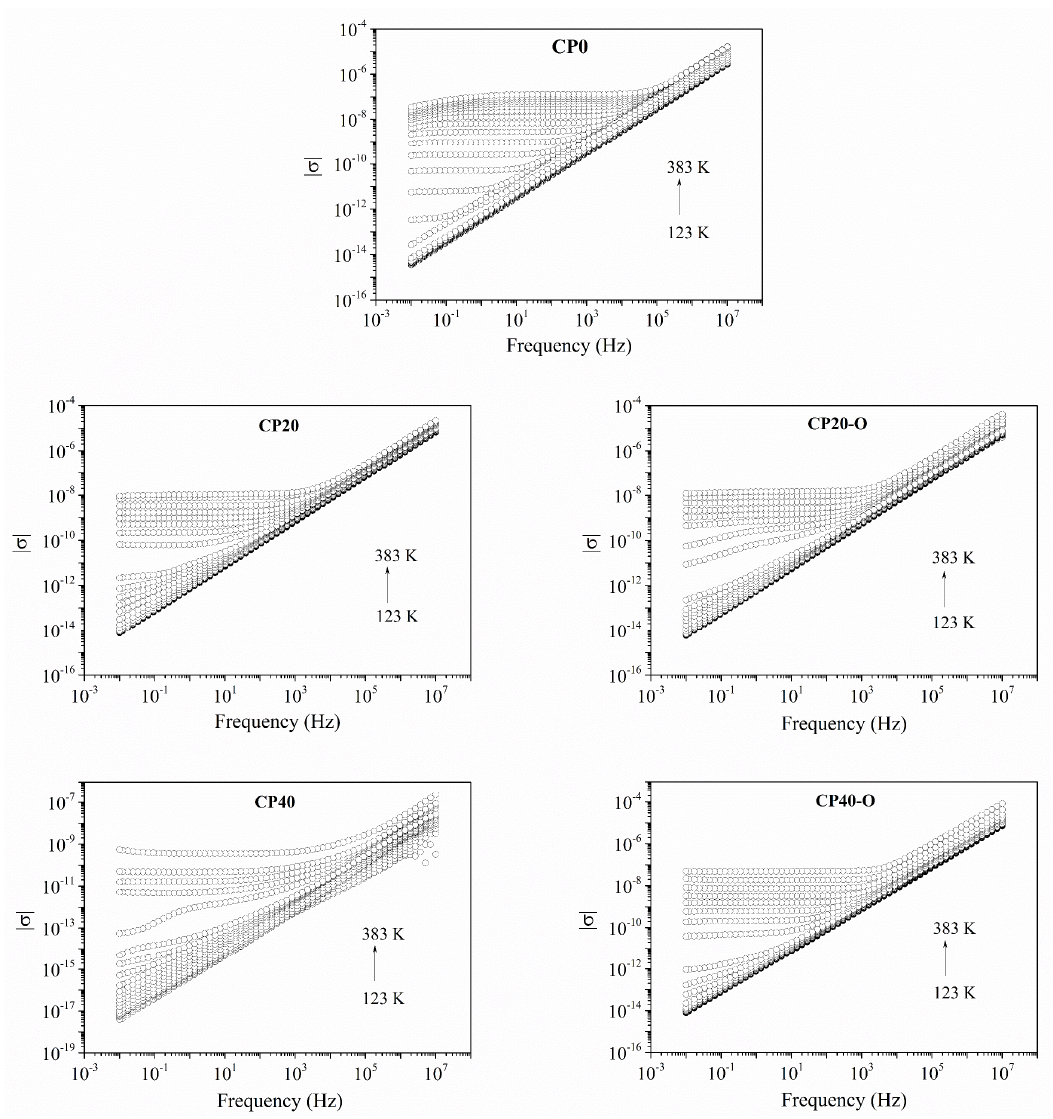
Figure 11. Modulus of the electric conductivity (| σ |) for the modified unoriented (CP20, CP40) and oriented (CP20-O, CP40-O) copolymers.